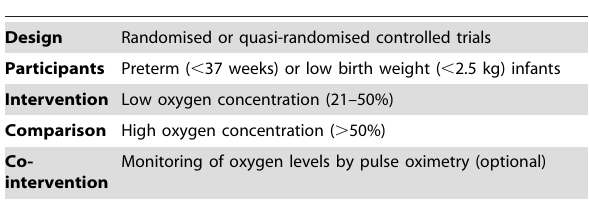
Table 1. Inclusion